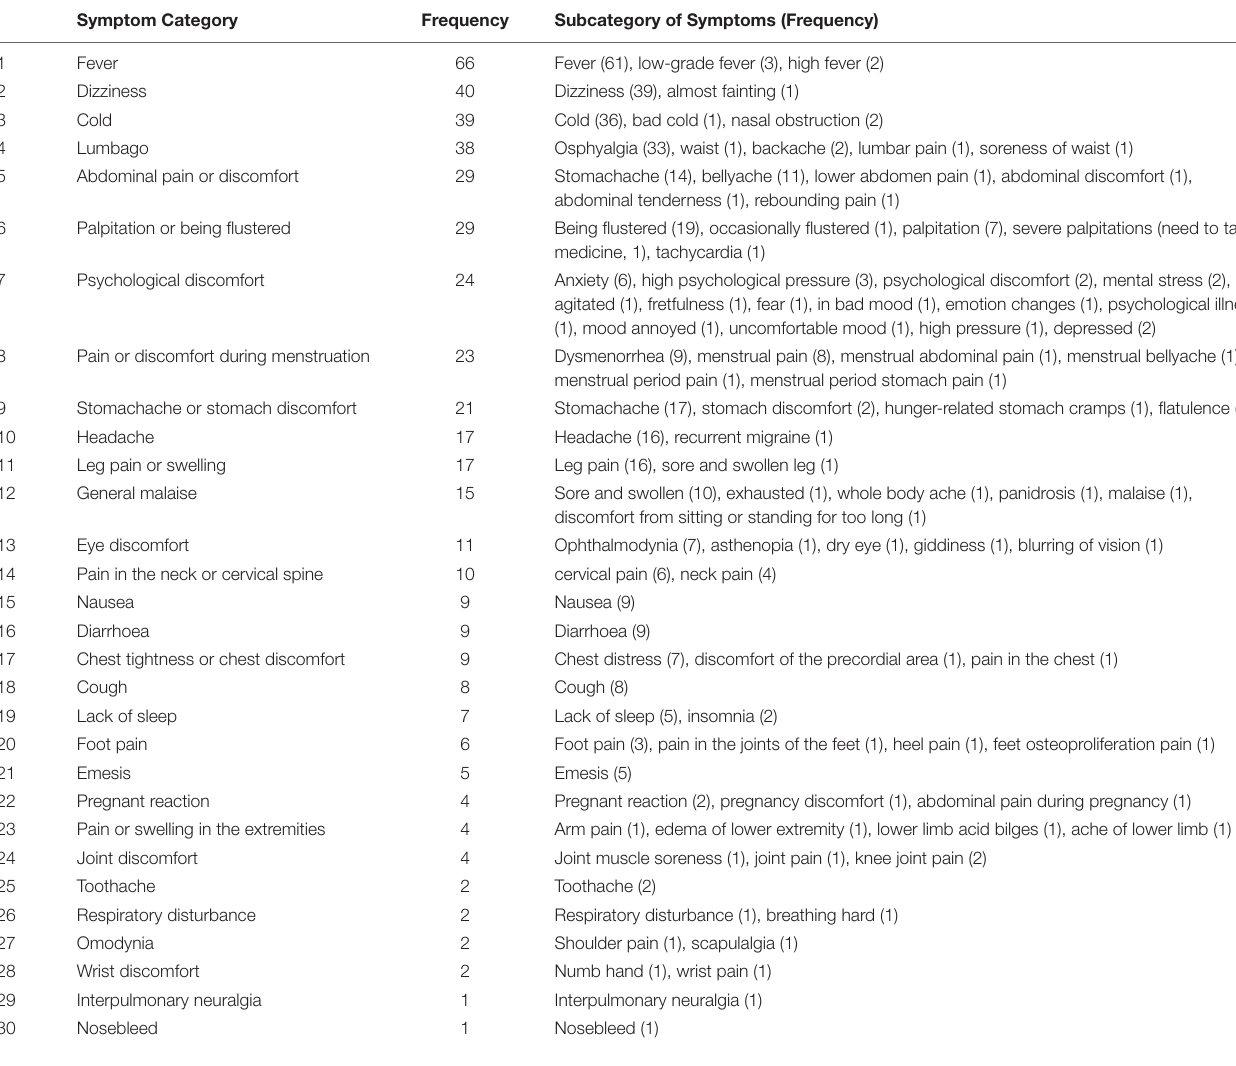
TABLE 2 | Preliminary summary of symptom